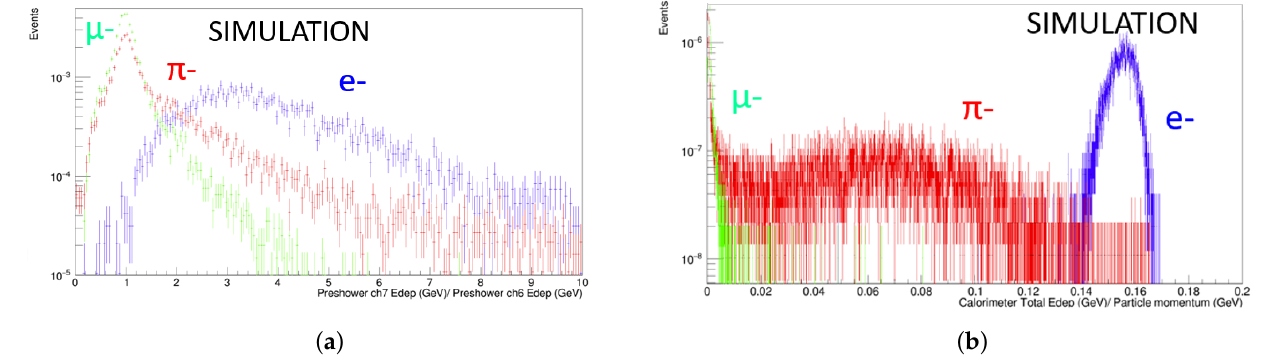
Figure 14. Test beam simulation PID plots showing 200 GeV pion (green), 150 GeV muon (red), and 30 GeV electron (blue) simulated signals. ( a ) The ratio of deposited energy (GeV) in the two pre-shower station scintillator layers. ( b ) The ratio of deposited energy in the calorimeter and particle momentum